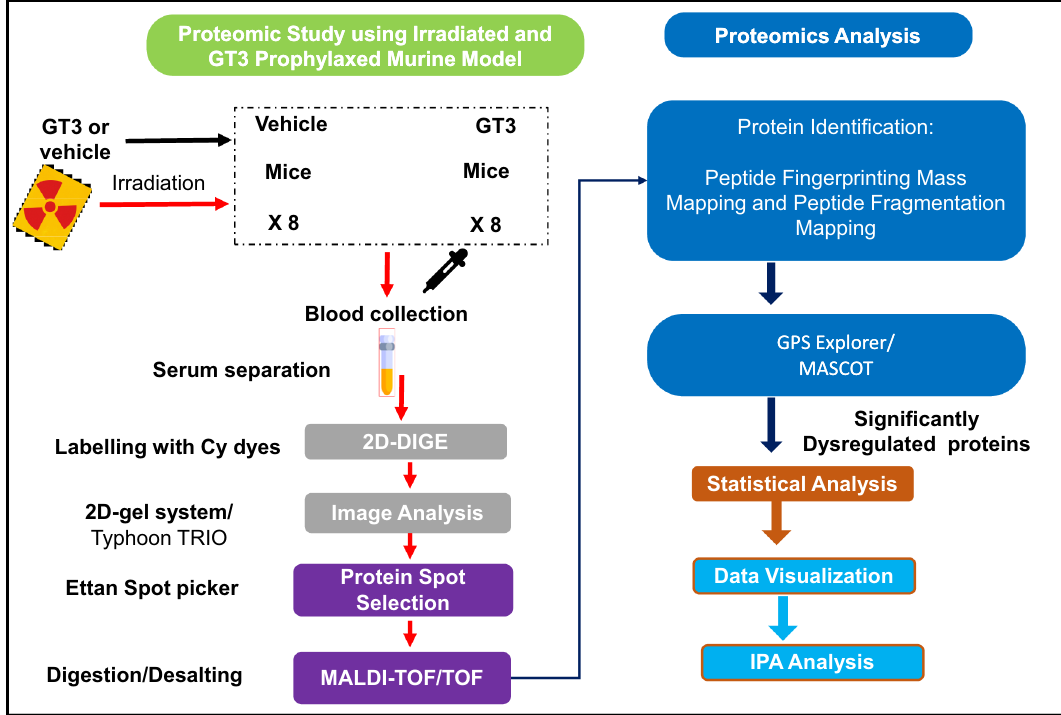
Figure 2. Study outline. Schematic of the animal study, sample preparation, and subsequent data